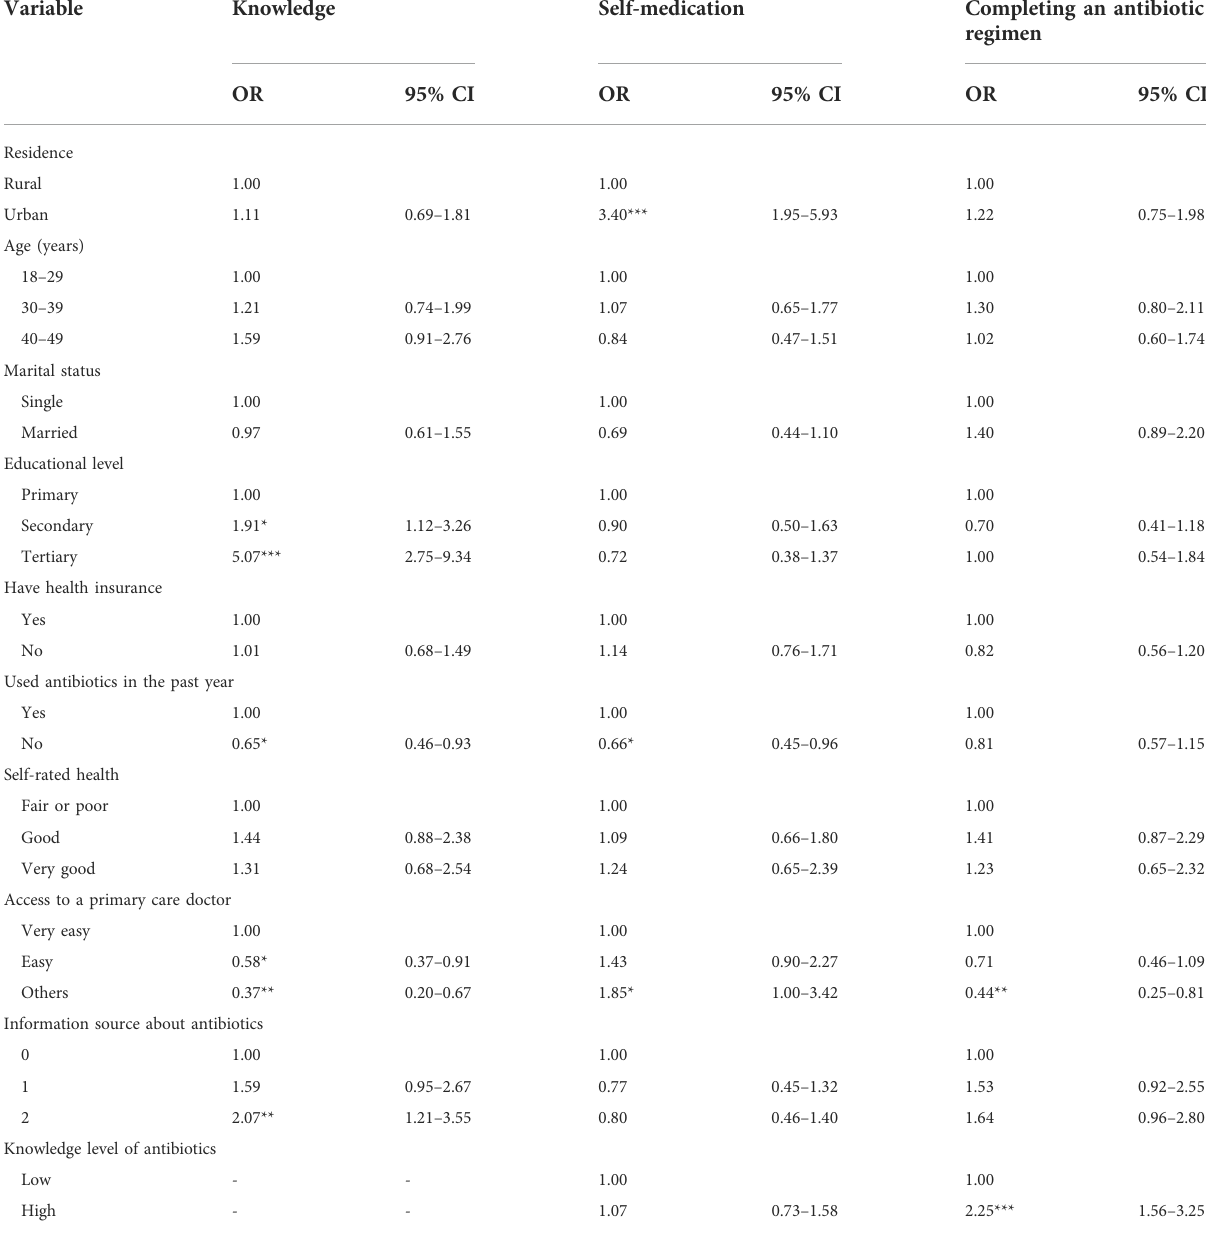
TABLE 4 Multivariate analysis of factors associated with self-medication of antibiotics and completing antibiotics